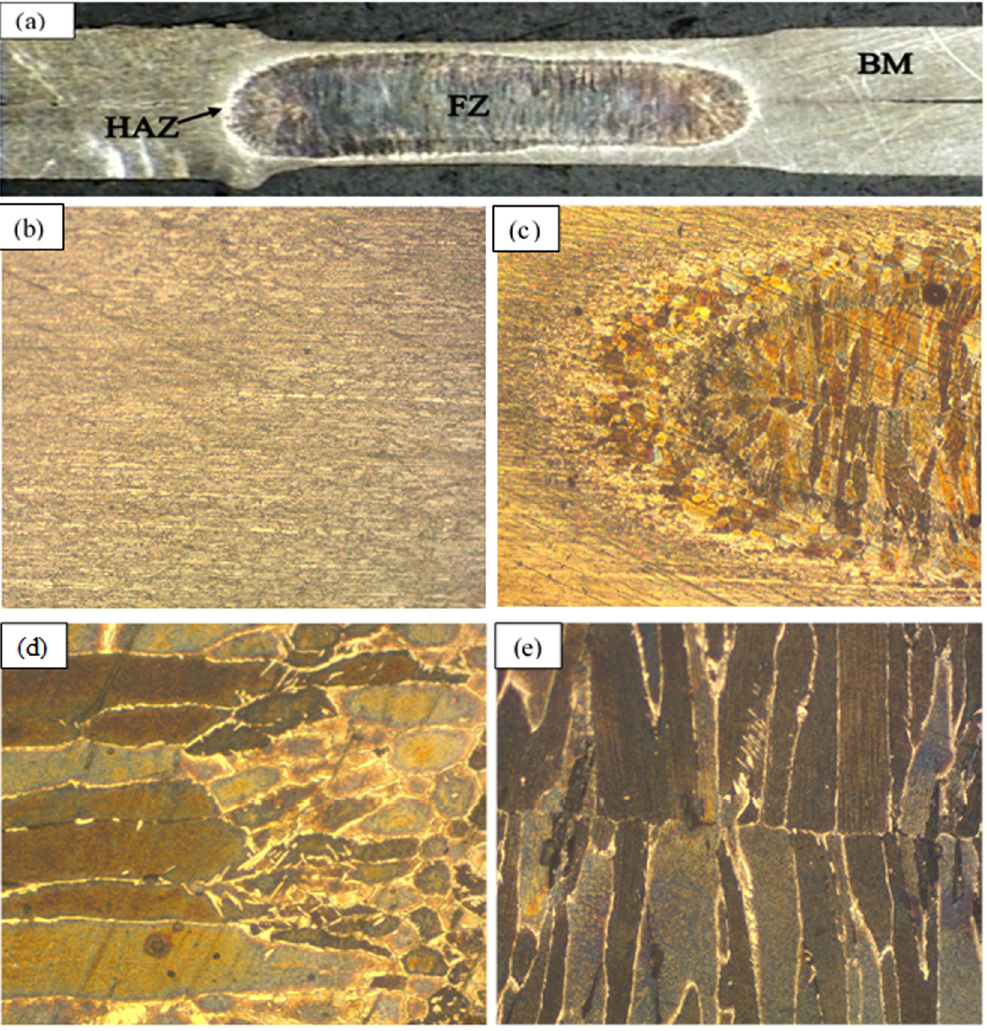
Figure 2: Macro/microstructure of 2205 DSS spot welded joint: ( a ) macrostructure, ( b ) BM microstructure, ( c ) BM/HAZ/FZ interface, ( d ) equiaxed grain/columnar grain interface and ( e ) columnar grain structure at FZ centre ( lighter phase is austenite and darker one is ferrite )